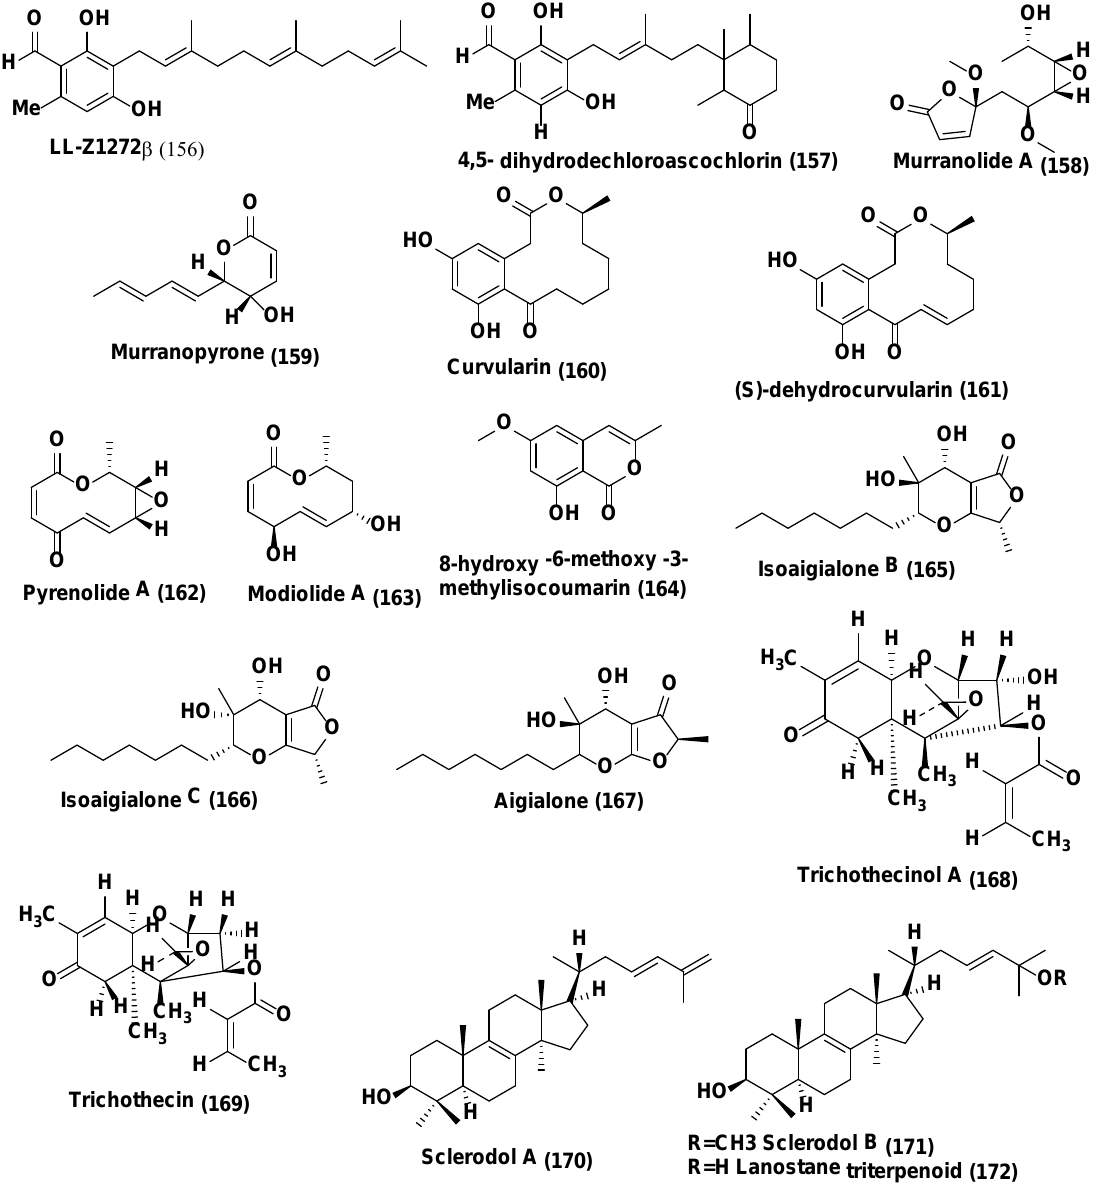
Figure 8. Structures of metabolites isolated from Hyphomycetes ( 156 – 169 ) and Basidiomycetes ( 170 – 172 ).